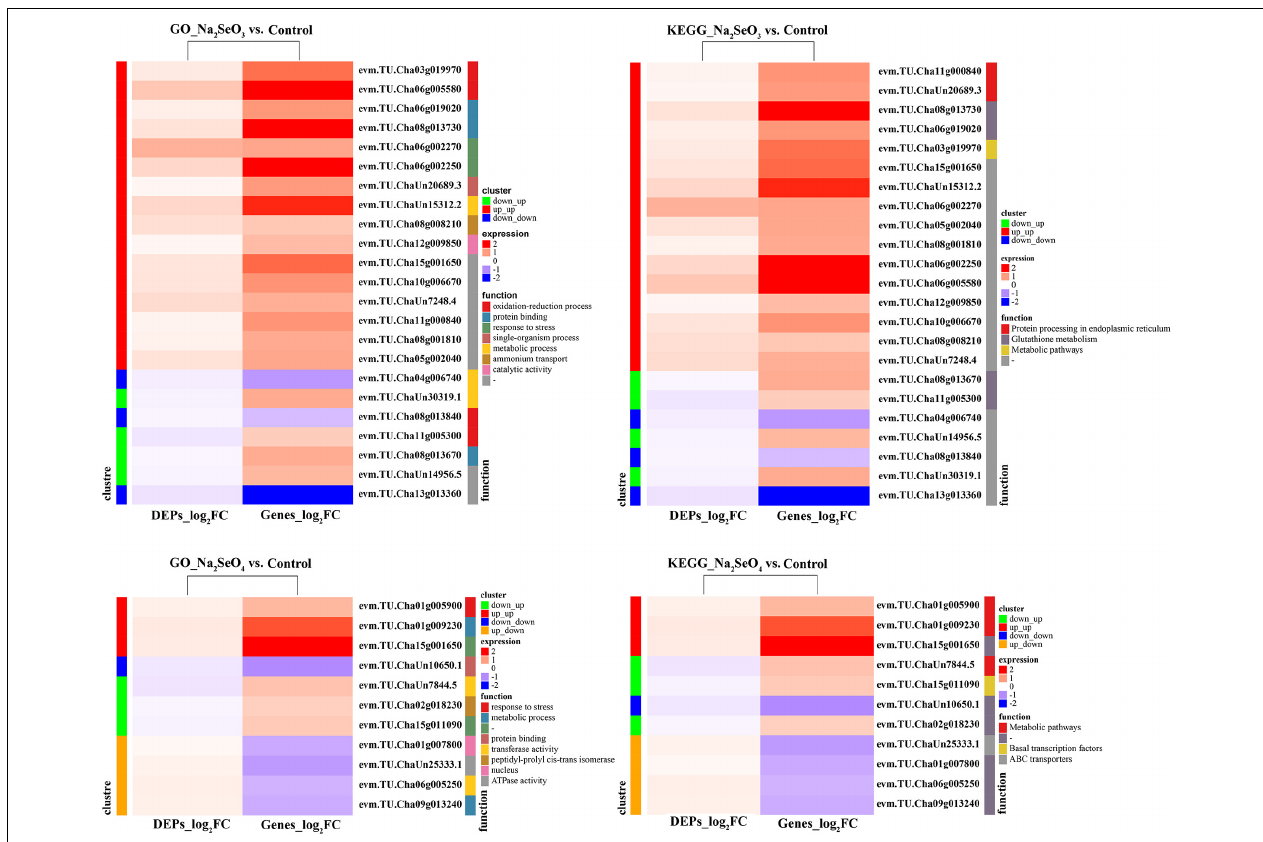
FIGURE 7 | Heatmap of GO enrichment and KEGG pathway analyses of DEPs and their corresponding